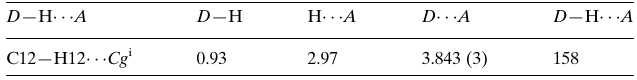
Hydrogen-bond geometry (A˚ , (cid:2) ). Cg is the centroid of the C18–C23